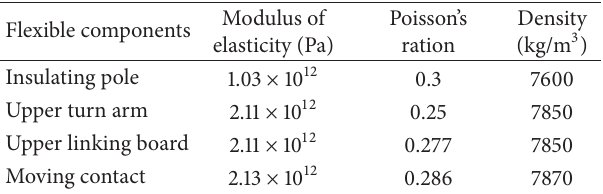
Table 2: The material properties of the flexible components. Flexible components